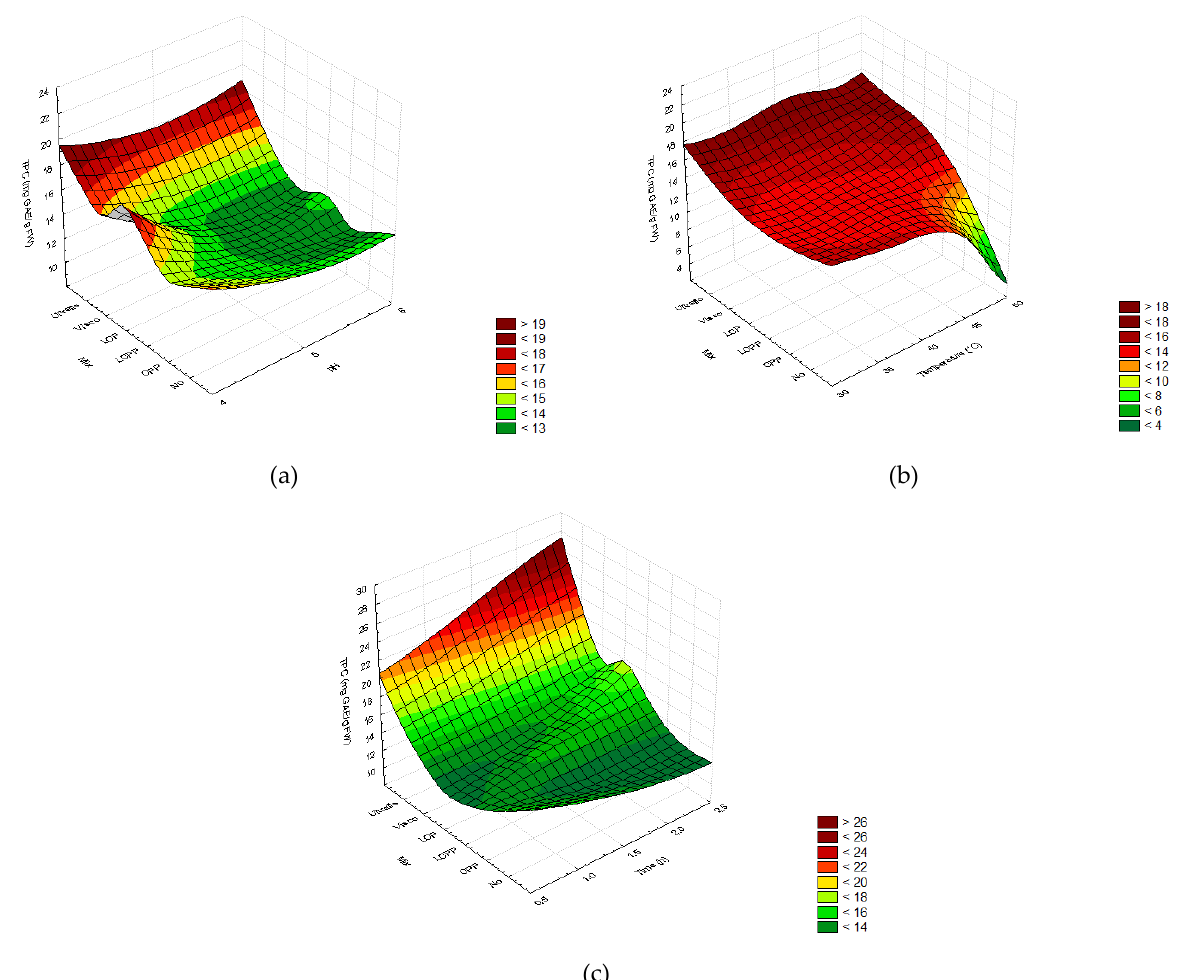
Figure 5. The total phenolic content (mg GAE/g FW) in the ethanolic extracts plotted as a function of the different enzymatic cocktails and; ( a ) pH (4–6), ( b ) temperature (30–50 ◦ C), and ( c ) time (0.5–2.5 h). In order; two commercial cocktails: Ultraflo© (Ultraflo) and Viscozyme© (Visco); three formulated cocktails with laccase, cellulase, and pectinase in proportion 1:1:1 (LCP), 1:1:2 (LCPP), and 0:1:2 (CPP); and the control without enzymes added (No). The color scale indicates the significance of the analysis of variance for the Taguchi method (n = 3, p >